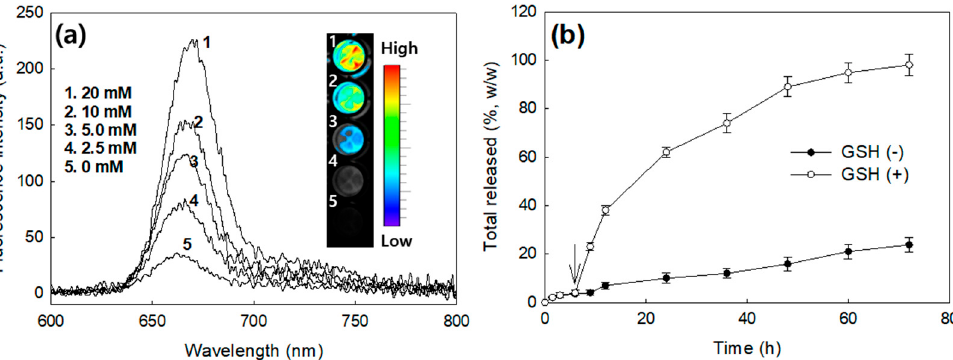
Figure 3. ( a ) Effect of GSH concentration on the fluorescence spectra of FA–PEG 3500 -ss-Ce6tri copolymer nanophotosensitizers. For fluorescence images, nanophotosensitizer solution (0.1 mg/mL) in PBS (pH 7.4, 0.01 M) was incubated at 37 °C for 3 h with GSH; ( b ) Ce6 release from FA–PEG 3500 -ss-Ce6tri copolymer nanophotosensitizers in the presence or absence of GSH. GSH concentration in the media was 0 mM for GSH(-) and 20 mM for GSH(+).